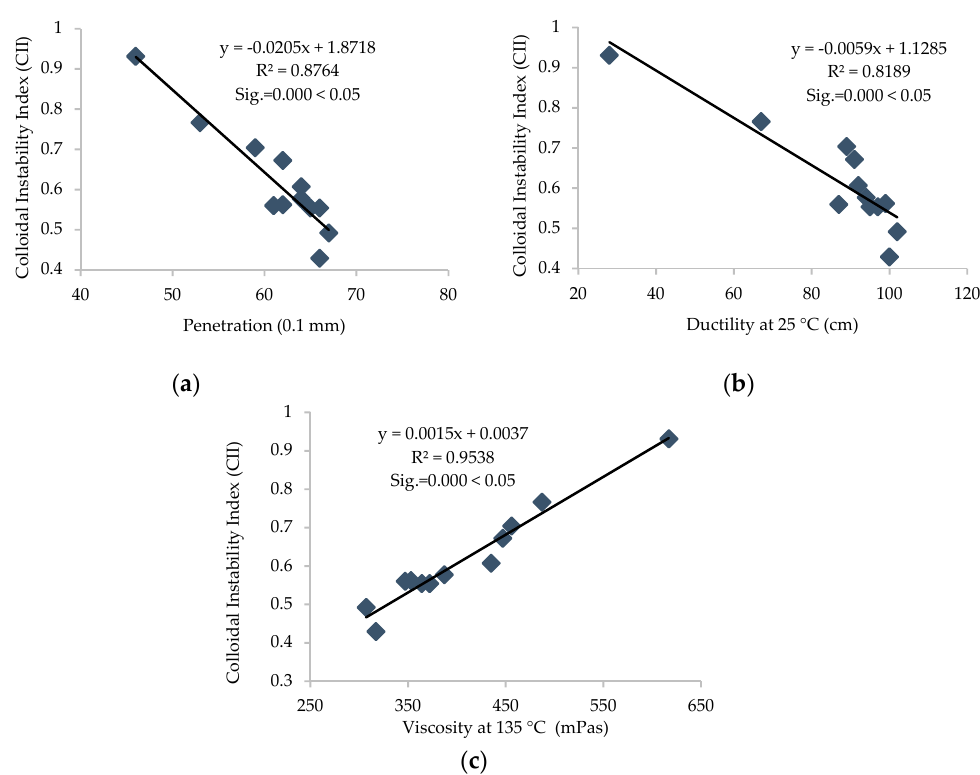
Figure 15. Correlation between CII and physical properties of all samples of binders. ( a ) Penetration (0.1 mm), ( b ) Ductility at 25 °C (cm), ( c ) Viscosity at 135 °C (mPas).